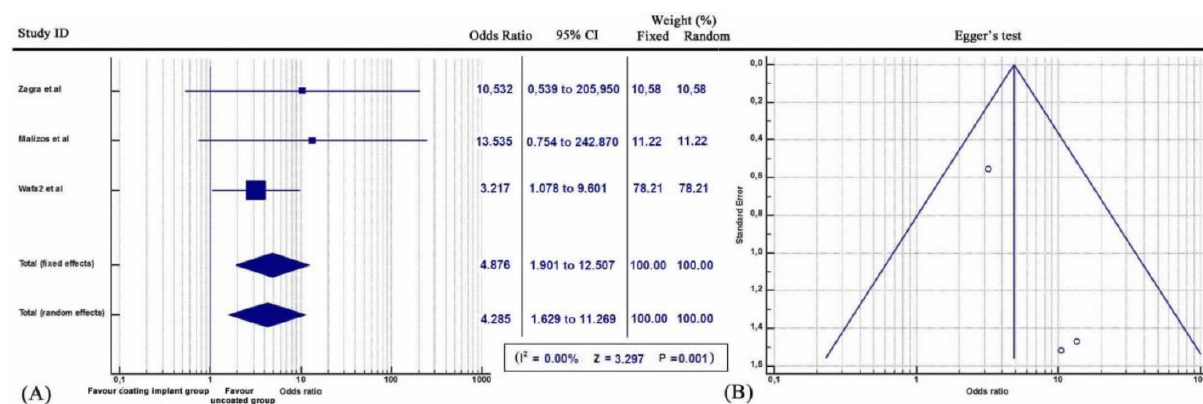
Figure 5. (A) Forest plot showing the likelihood of periprosthetic infections including three patients categories (a) with post-operative infections, (b) with primary sarcomatous and metastatic bone cancers and (c) after primary joint replacement arthroplasty in the coating implant group versus the group without coating implants. (B) Funnel plot of the Egger’s test was utilized to assess for publication bias.